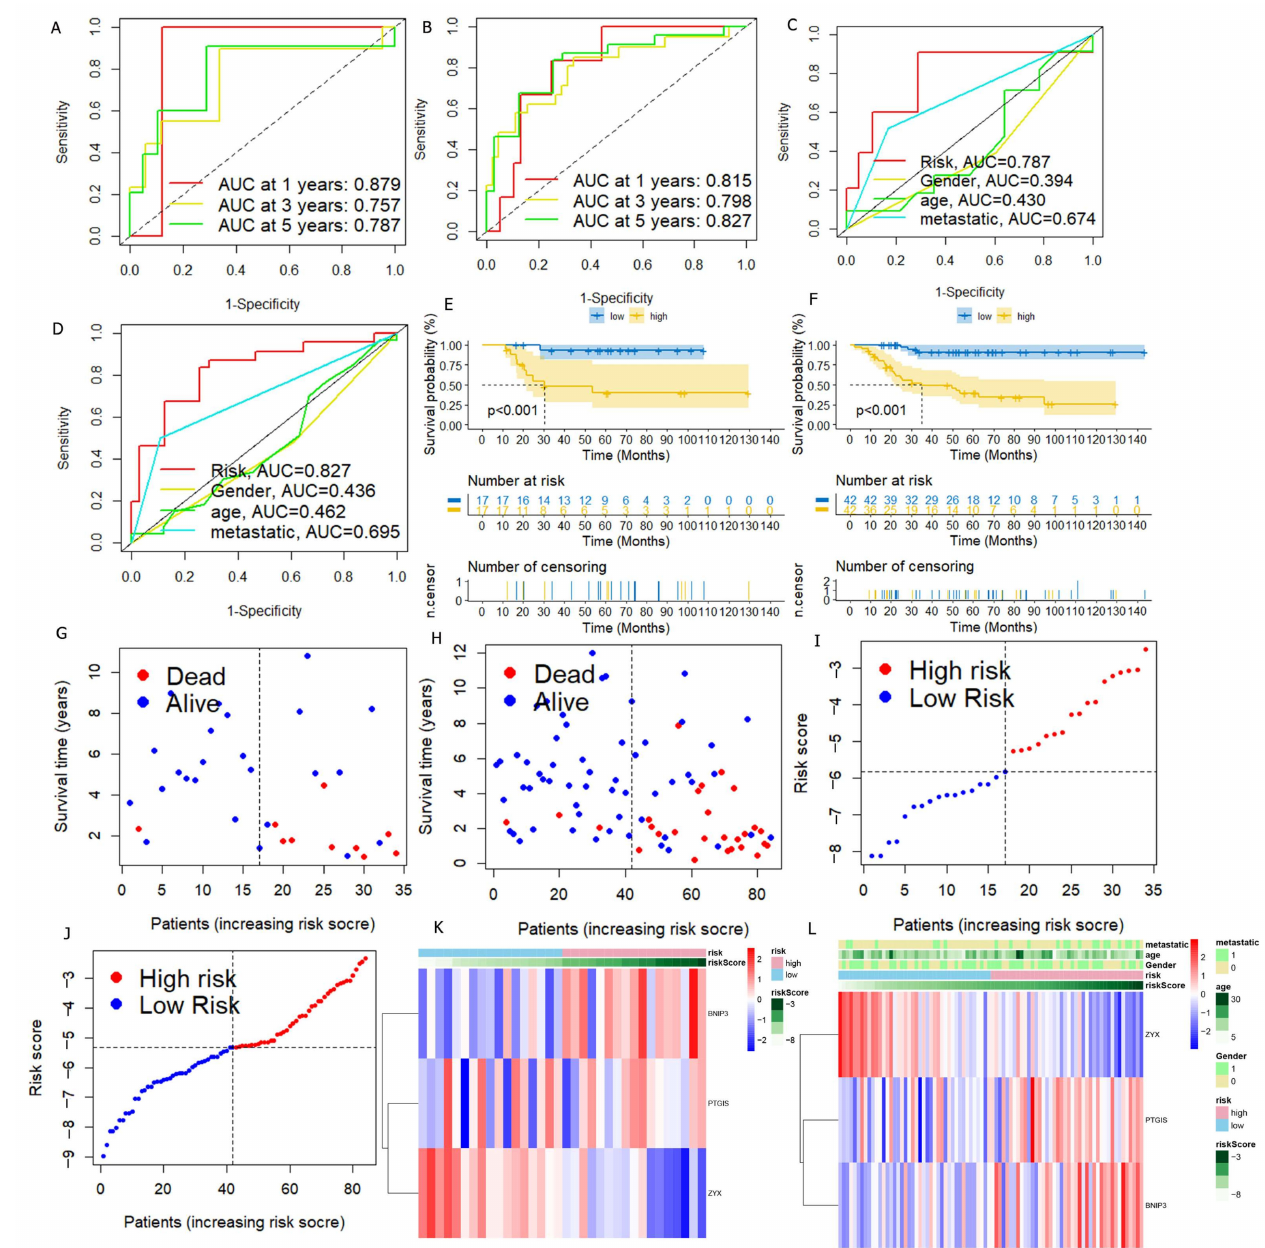
Figure 5. Verification of DGPS. ROC curve of DGPS in the test set ( A ) and in the entire cohort ( B ). ROC demonstrated that the predictive accuracy of DGPS was superior to that of other clinical characteristics in the test set ( C ) and in the entire cohort ( D ). Kaplan–Meier curves of overall survival (OS) in the test set ( E ) and in the entire cohort ( F ). Survival status of patients with osteosarcoma in the test set ( G , I ) and in the entire cohort ( H , J ). Blue: low risk; red: high risk. The heatmap indicates the expression degrees of BNIP3, PTGIS, and ZYX in the test set ( K ) and in the entire cohort ( L